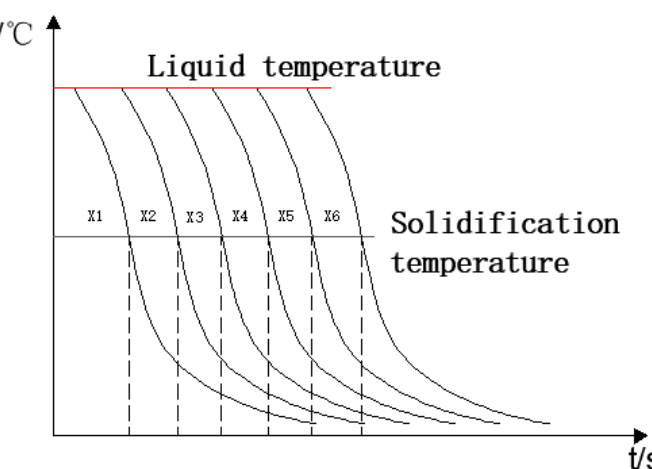
Figure 2. Temperature dynamic curve during